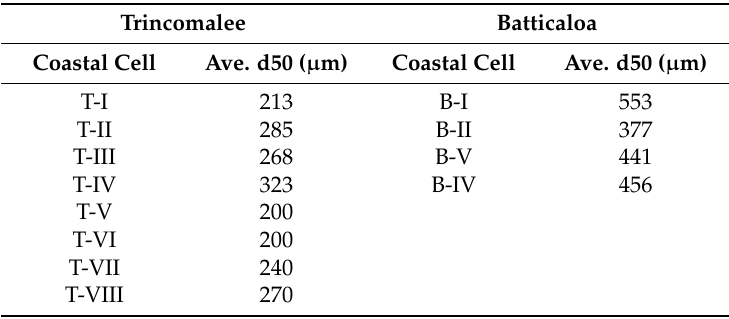
Table 1. Average d50 measured in each coastal